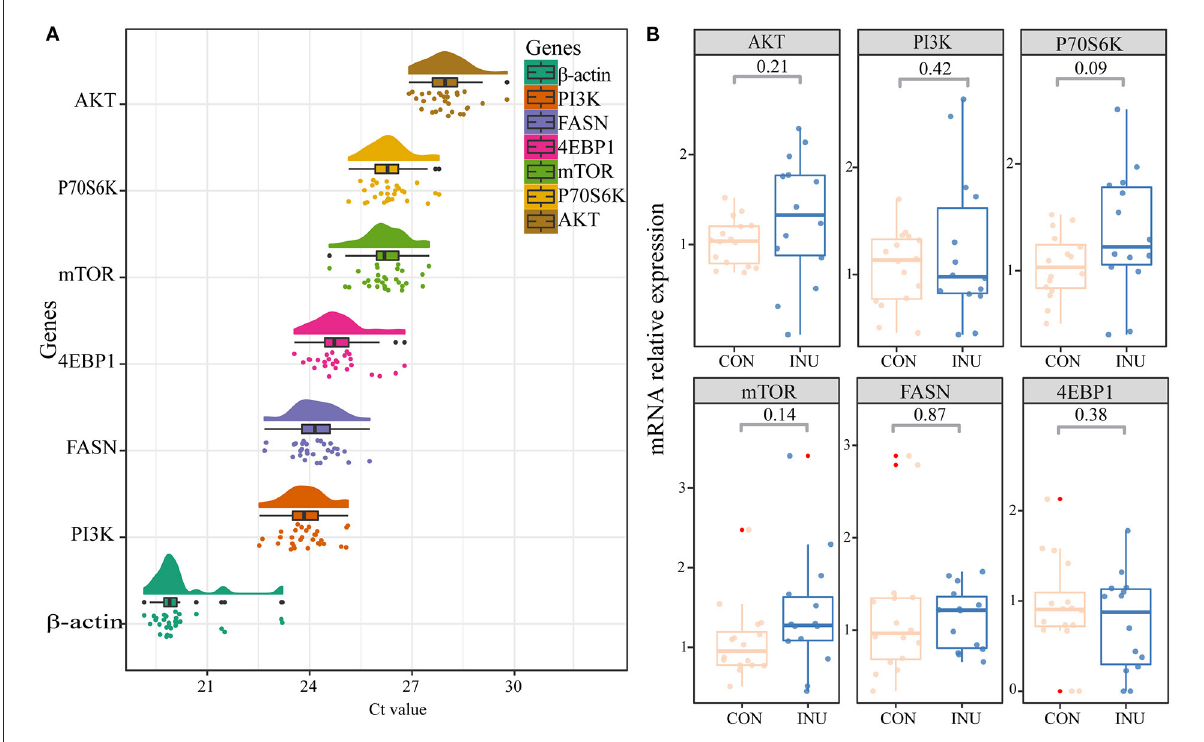
FIGURE6 Expression of key genes in mTOR signaling pathway of longissimus dorsi muscle of weaned kids fed maize-grain based diet (CON) or low-carbon high inulin diet (INU). (A) is the cloud and rain map of gene expression ct value, (B) is the mTOR signaling pathway gene